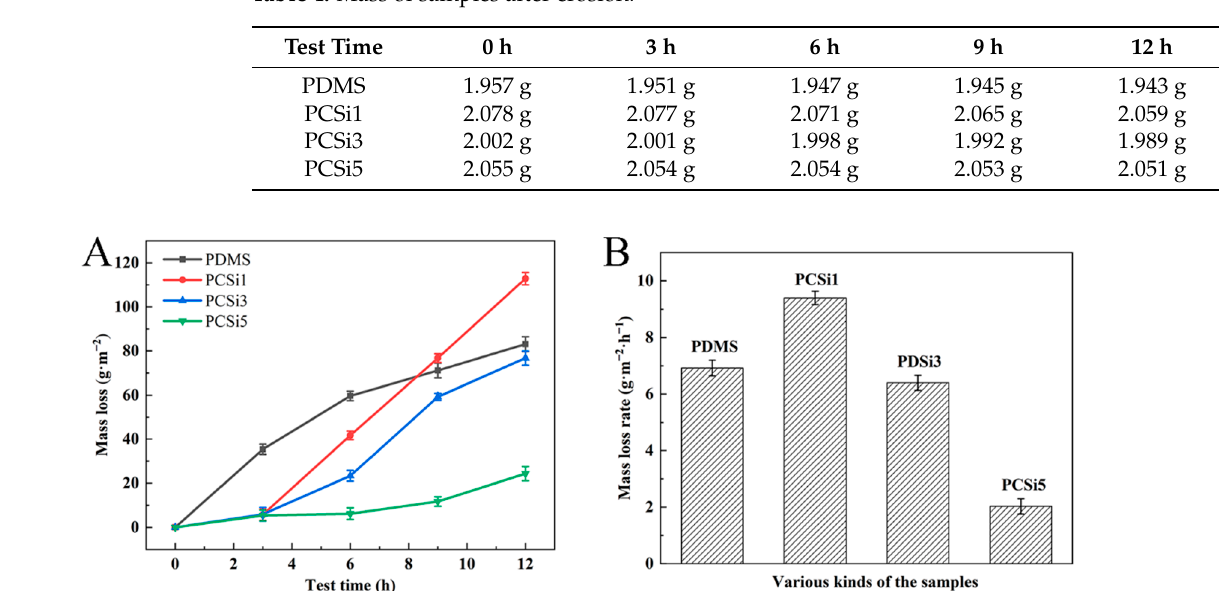
Figure 7. Mass loss versus time curve ( A ) and mass loss rate of the samples ( B ).